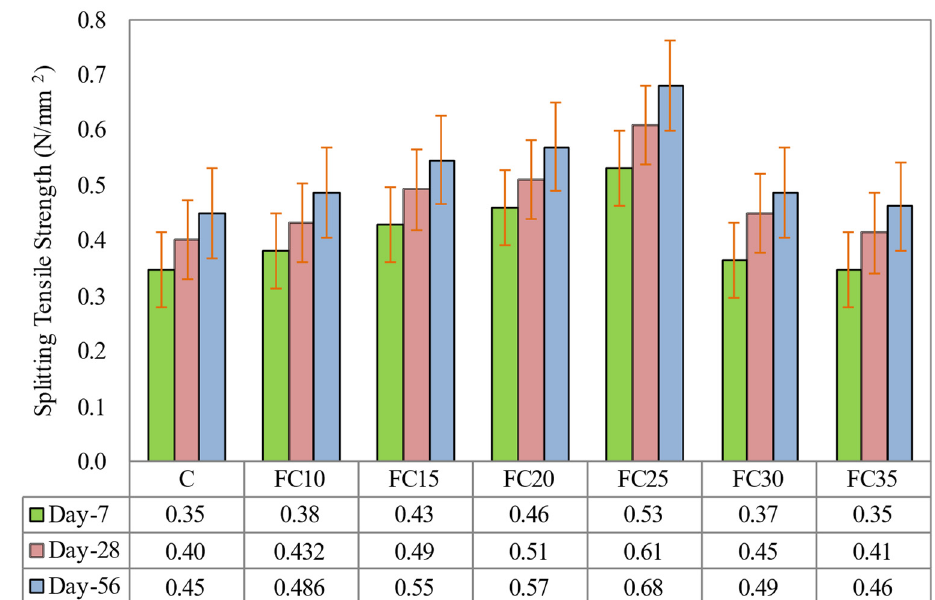
Figure 11. Influence of different weight fractions on splitting tensile strength of LFC.